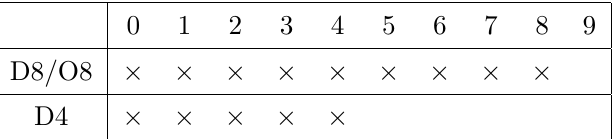
Figure 1 . Juxtapositions for various physical quantities in the Seiberg E 8 theory of results obtained by numerically computing the perturbative partition function (squares), and by the large N formula (dashed line). The physical quantities considered here are the round sphere free energy (cid:0) F 0 , the conformal central charge C T , the mesonic (cid:13)avor central charge C SU(2) M , and the exceptional (cid:13)avor J central charge C E 8 . The numerical computations are done by direct integration up to N = 3, and J by saddle point approximation up to N = 40.